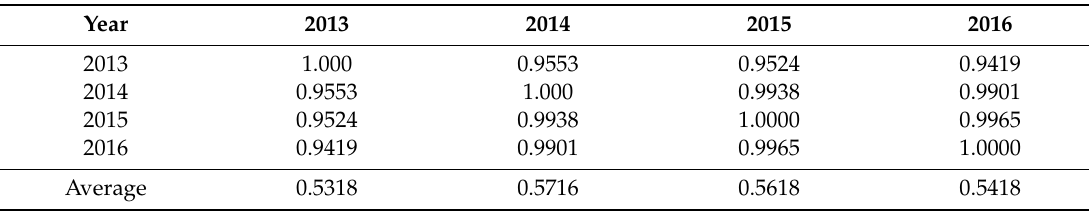
Table 3. Correlation test of e ffi ciency values from 2013 to